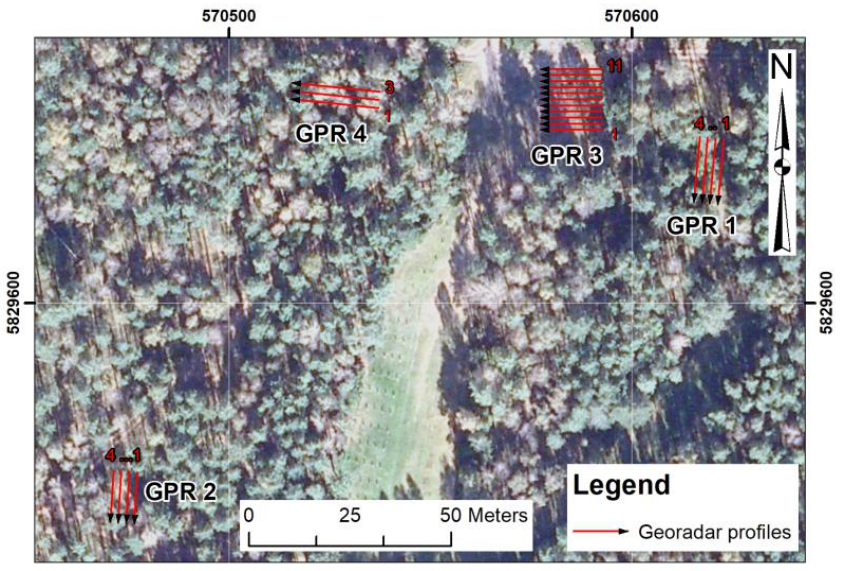
Figure 5. The location of ground-penetrating radar survey profiles (GPR). Coordinate grid: Polish Coordinate System 1992 (EPSG: 2180). Copyright: Head O ffi ce of Geodesy and Cartography in